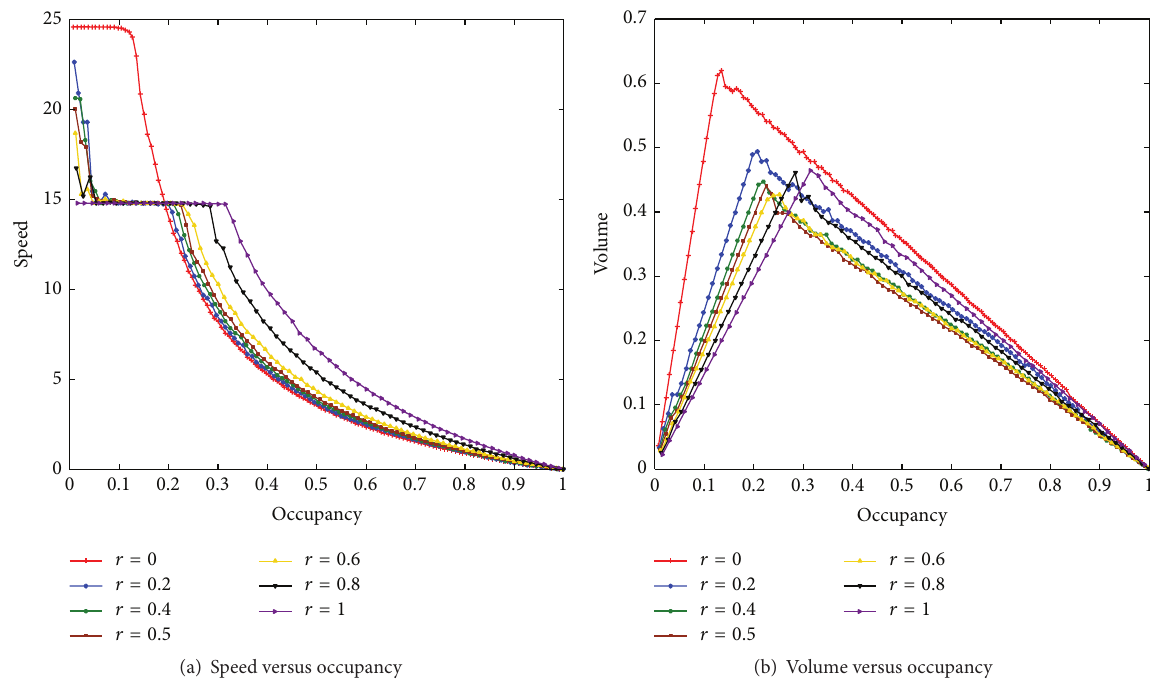
Figure 2: The fundamental diagram under different 𝑟 when imp =